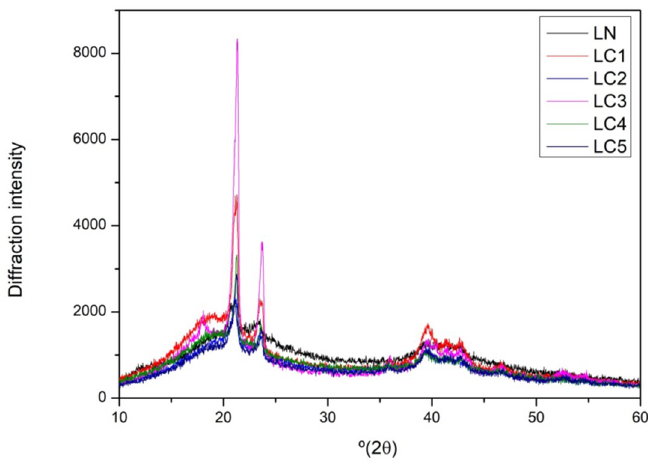
Figure 5. X-ray di ff raction profiles of LN and LC1 (DS: 0.32), LC2 (DS: 0.47), LC3 (DS: 0.51), LC4 Figure 5. X-ray diffraction profiles of LN and LC1 (DS: 0.32), LC2 (DS: 0.47), LC3 (DS: 0.51), LC4 (DS: (DS: 0.58), and LC5 (DS: 0.58), and LC5 (DS: 0.68).